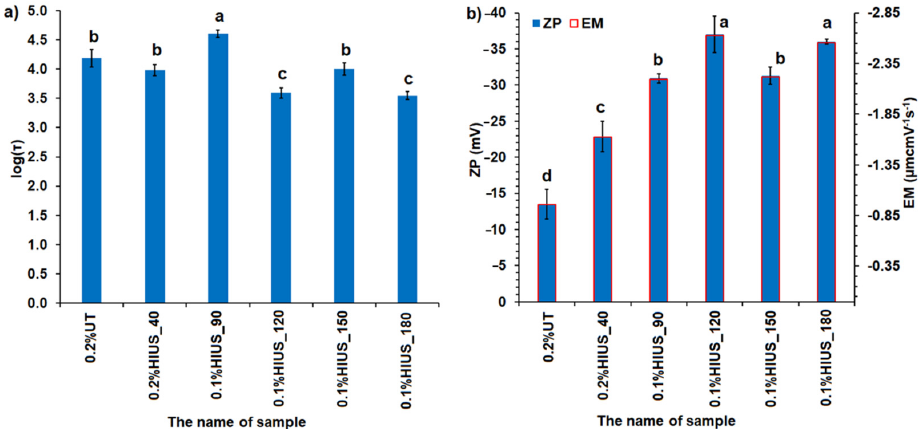
Figure 6. ( a ) The logarithm of the relaxation time marked as log( τ ) as well as ( b ) zeta potential (ZP) and electrophoretic mobility (EM) of cellulose; bars indicate standard deviation; different letters represent statistically significantly different results (one-way ANOVA and the Tukey’ HSD post hoc test, p < 0.05).